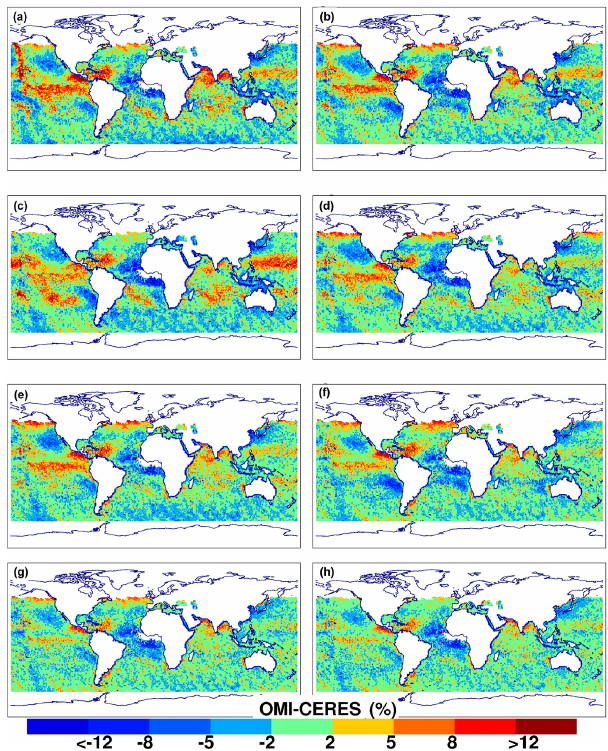
Figure 4. Monthly mean (January 2007) maps of OMI minus CERES TOA SW flux (percent) for eight different NN models. The letters on the map corresponds to model number in Table